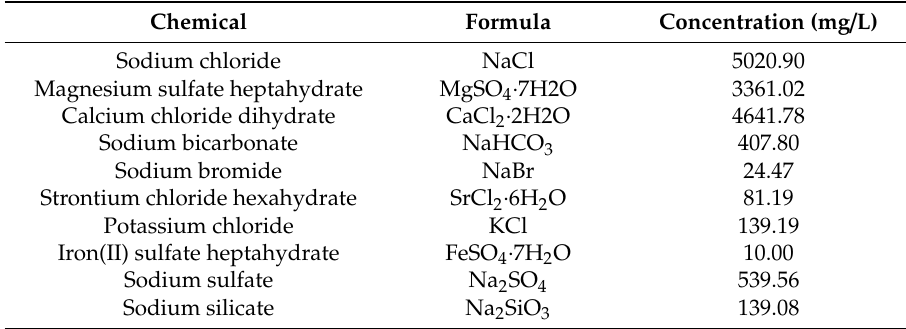
Table 5. Synthetic Produced Water